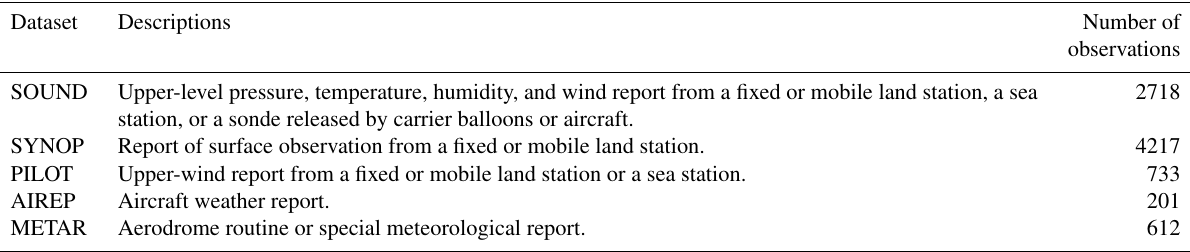
Table 1. Descriptions of the GTS datasets assimilated in the study.